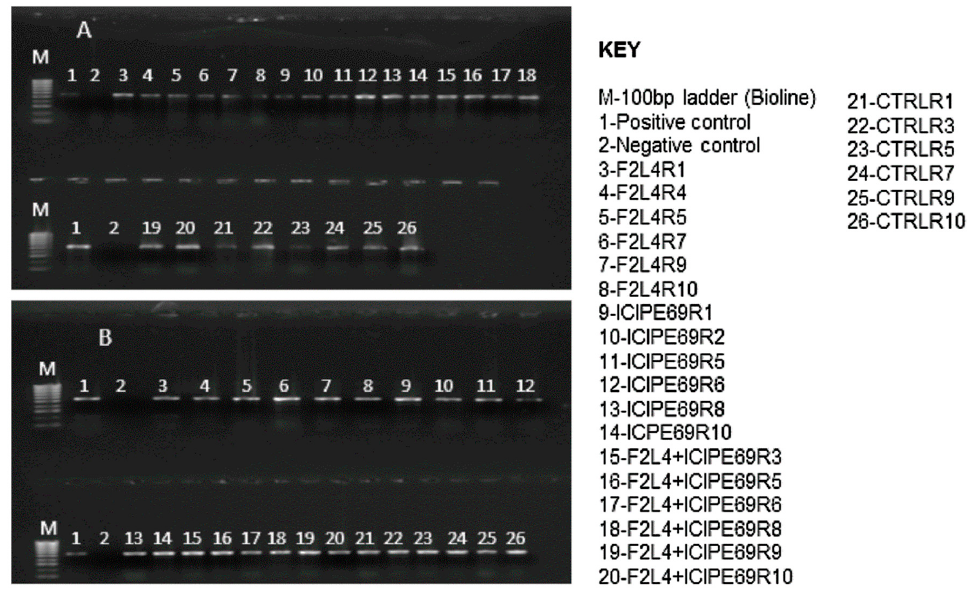
Figure 10. RT-PCR detection of Sugarcane mosaic virus ( A ) and Maize chlorotic mottle virus ( B ) in leaf samples of various treatments at 14 days post co-inoculation. F2L4 and ICIPE69 represent the fungal isolates, while R1–R10 represent the replicates that were randomly selected for evaluation.